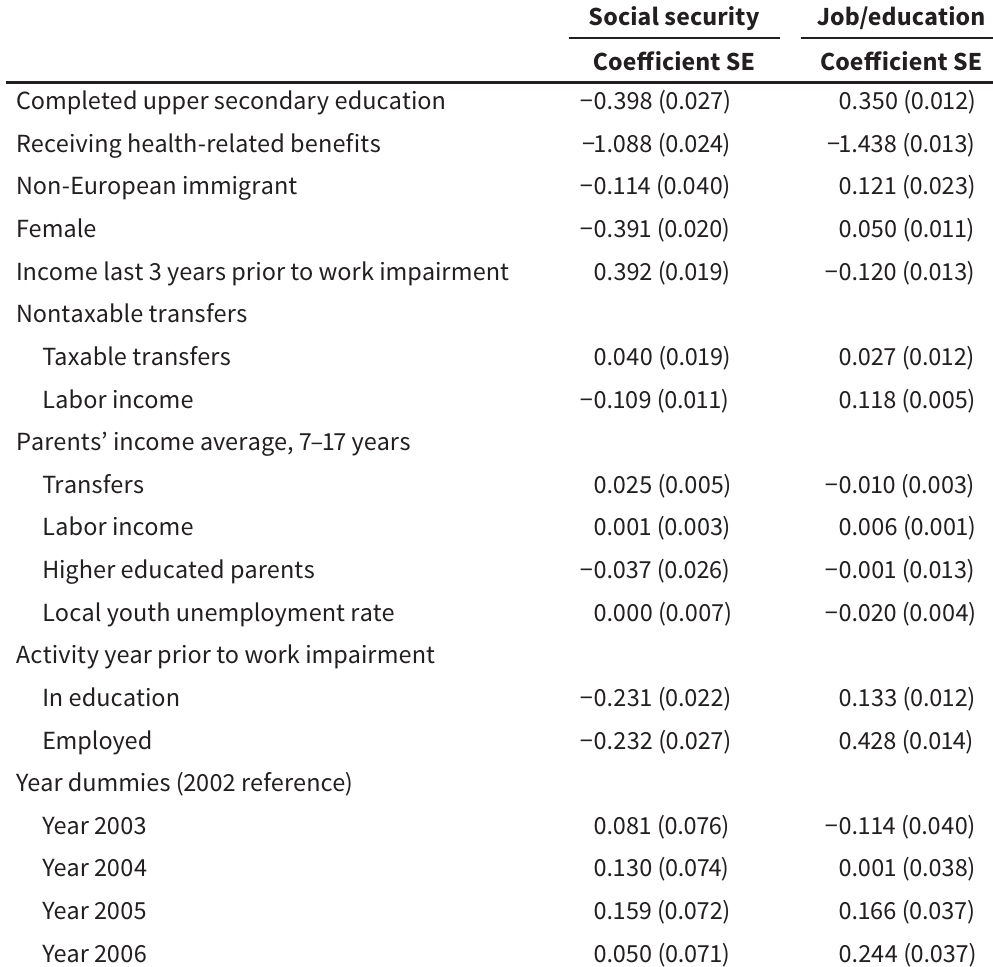
Complete estimation results: Transitions to outcome